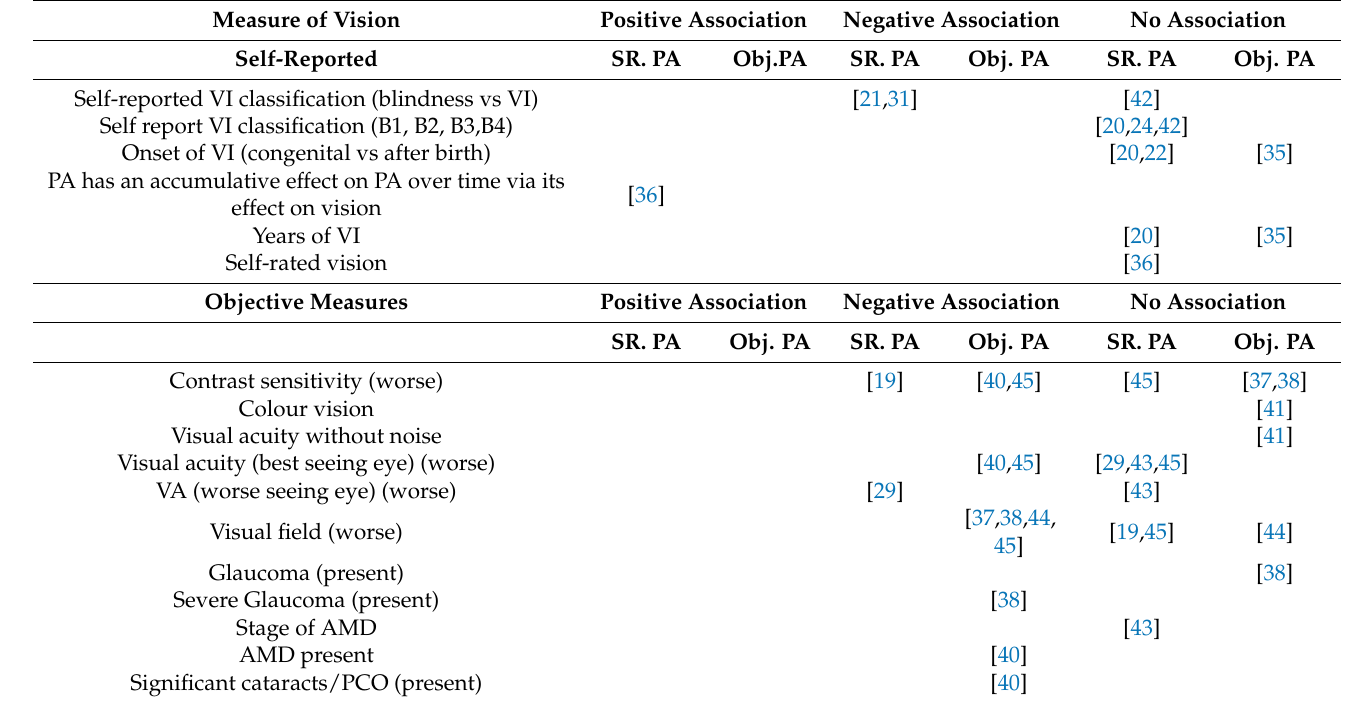
Table 3. Measures of vision and association with